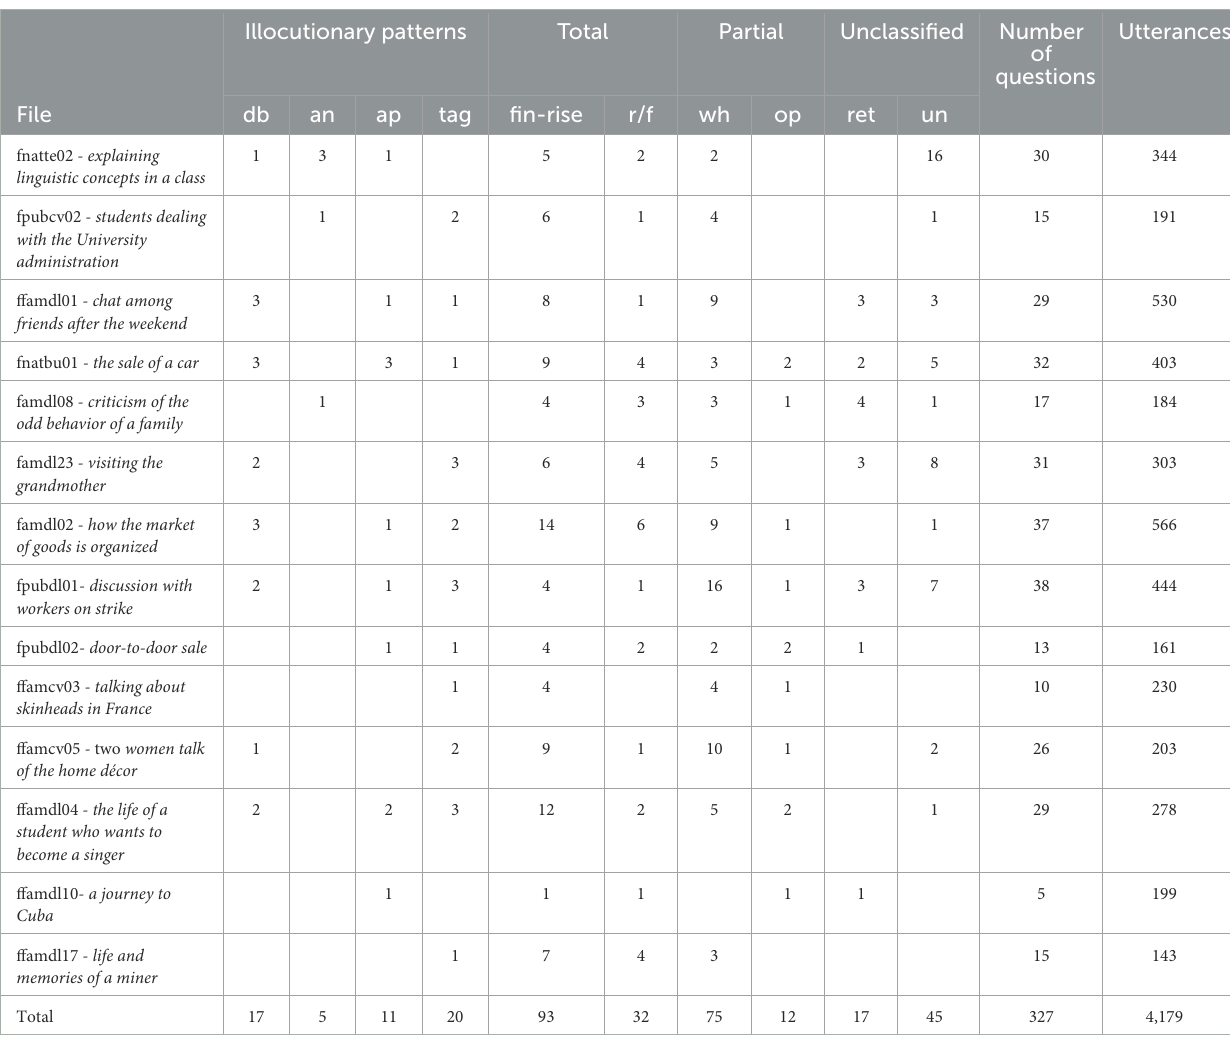
TABLE 2 The French data